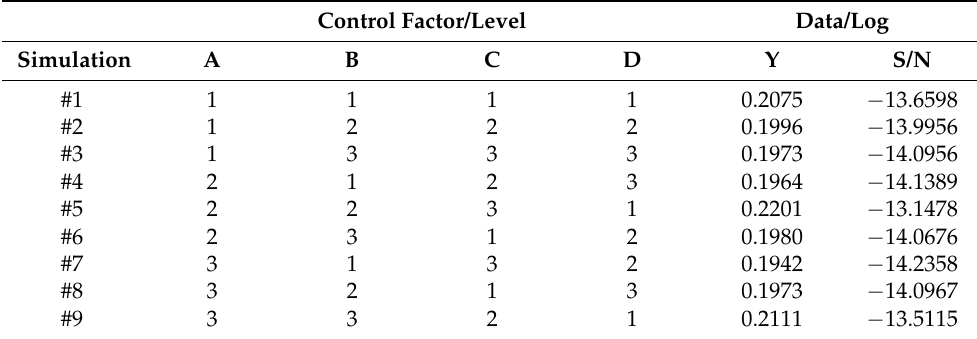
Table 4. Concave ANSYS simulation